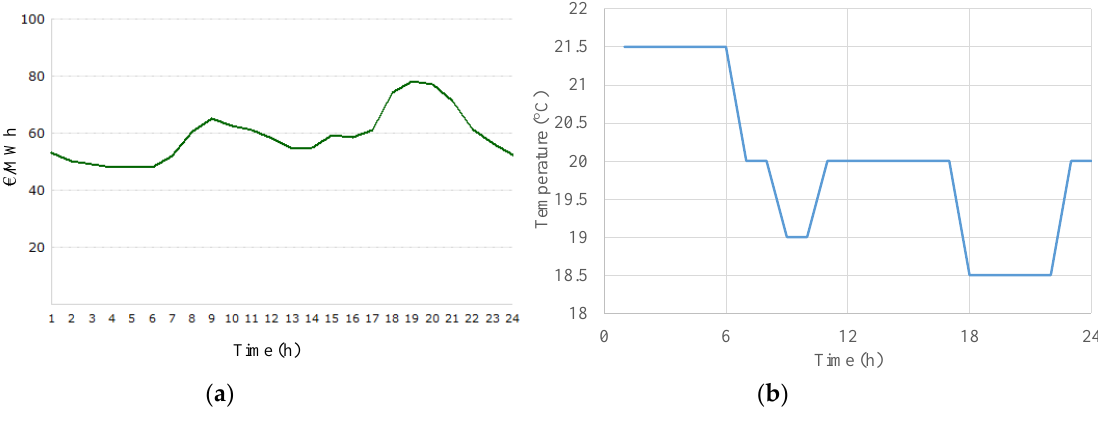
Figure 3. ( a ) Electricity market price on a winter’s day (2 January, 2017) and ( b ) daily internal temperature set-point profile.